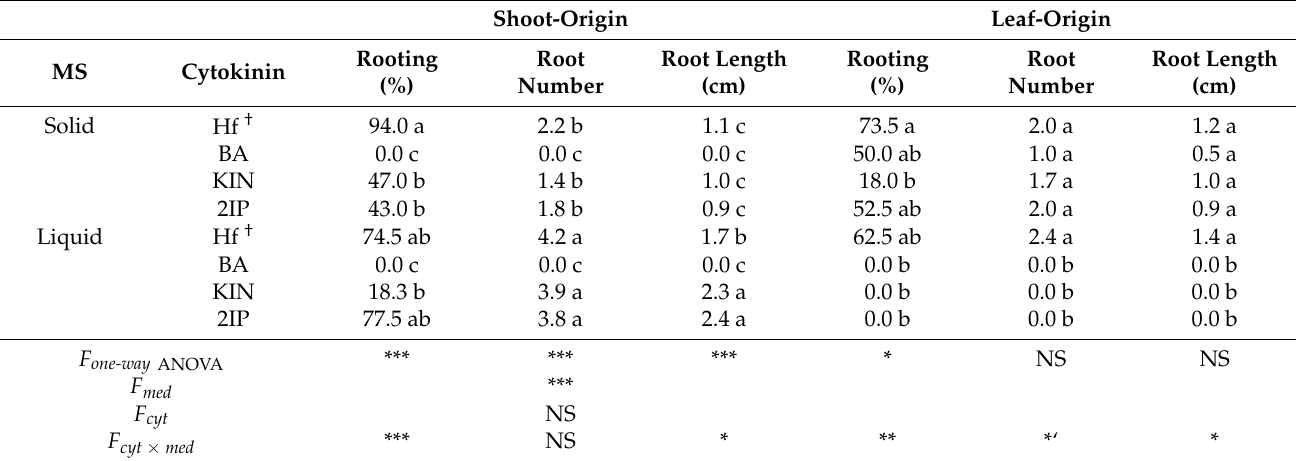
Table 6. In vitro rooting of shoots derived from shoots or leaves as affected by the type of MS (solid or liquid) and of cytokinin during multiplication stage.